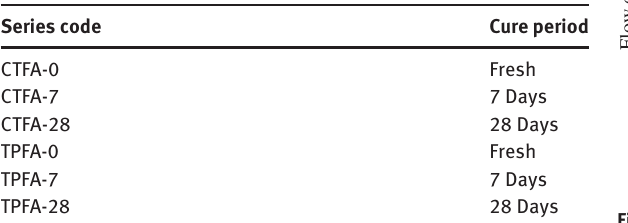
Figure 1 Flow values of fresh